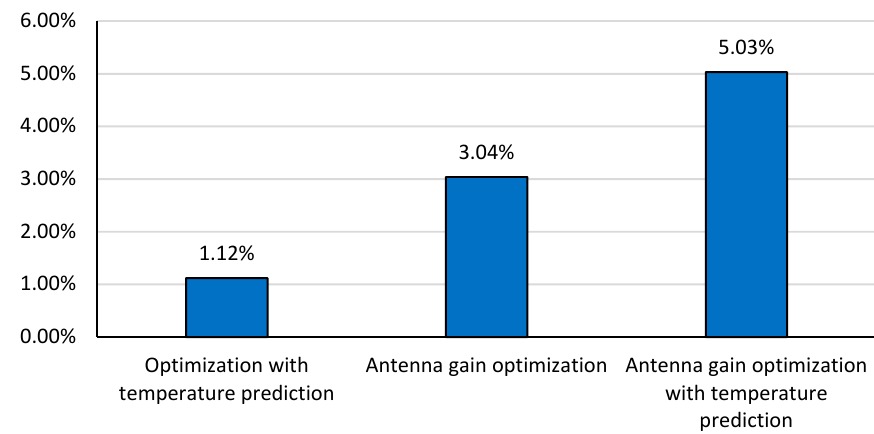
Figure 13. Graph showing the percentage decrease in power consumption of the end device as a result of the applied optimization algorithms.